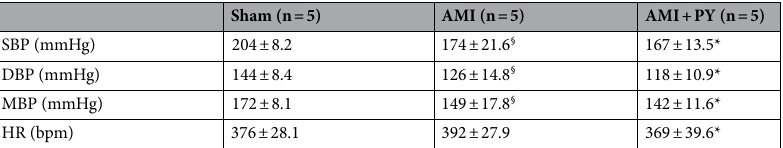
Table 1. Hemodynamic parameters in all three groups. Values expressed as mean ± SEM . § AMI versus Sham; * AMI + PY versus Sham. Values expressed as mean ± standard deviation. Sham: Control Group; AMI: Untreated Infarcted Group; AMI + PY: Infarcted Group Treated with Pyridostigmine SBP: Systolic Blood Pressure; DBP; Diastolic Blood Pressure, MBP = Mean Blood Pressure, HR: Heart rate. * p < 0,05; § p < 0,05. Statistical significance was determined by one-way ANOVA followed by a multiple comparisons test Tukey’s was performed using GraphPad Prism version 9.0.1. www. graph pad.